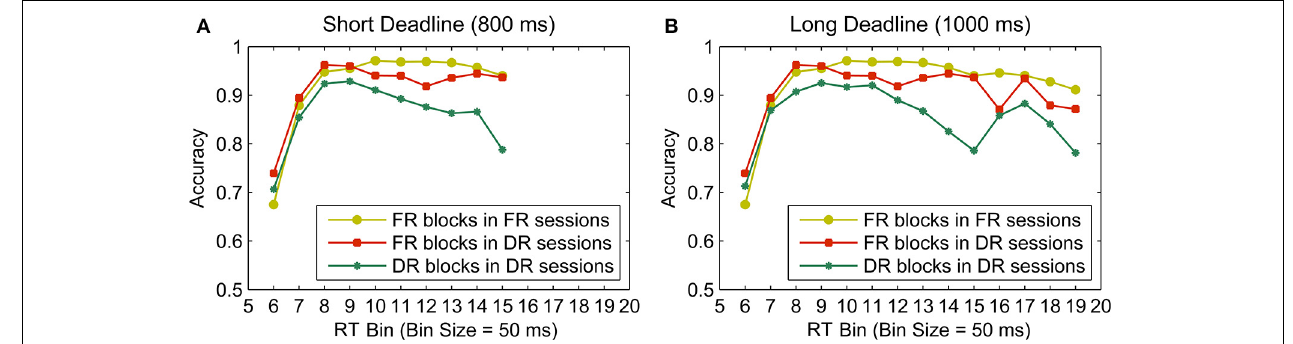
FIGURE 8 | Conditional accuracy curves for the FR blocks in FR sessions, FR blocks in DR sessions, and DR blocks separately for the short (A) and long (B) deadlines (800 and 1000ms,